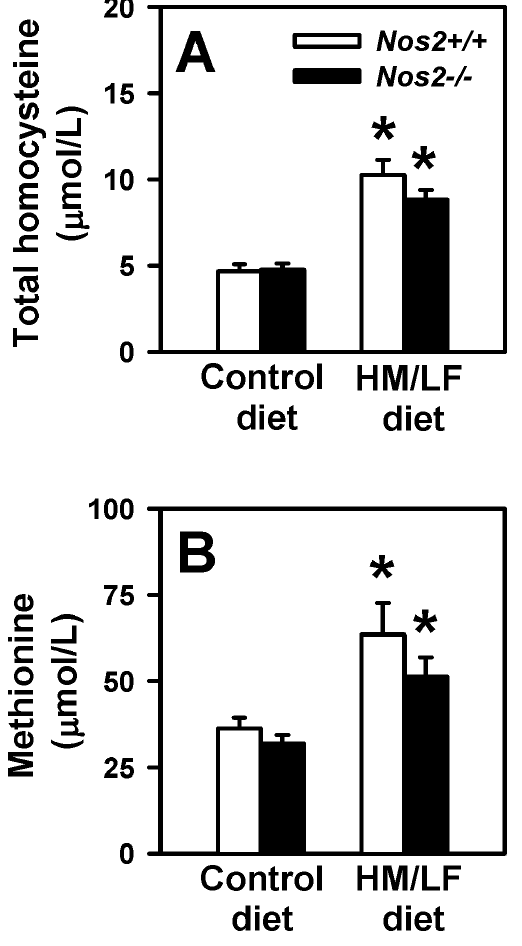
Figure 1. Plasma total homocysteine and methionine levels. Compared with mice fed the control diet, both Nos2 + / + (open bars) and Nos2 2 / 2 (filled bars) mice fed the HM/LF diet exhibited elevation in plasma total homocysteine and methionine levels. 15–20 mice were studied in each group. *P , 0.01 compared with mice of the same genotype fed the control diet by two-way